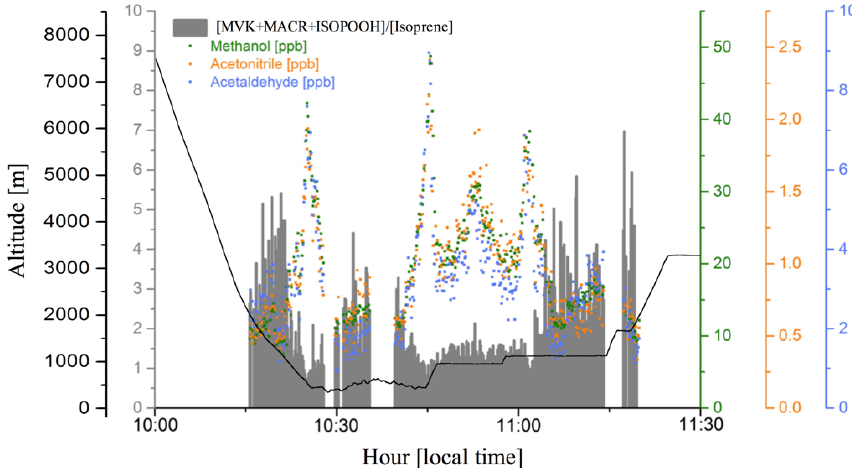
Figure 7. Methanol (green dots), acetonitrile (orange dots), and acetaldehyde (blue dots) mixing ratios (ppbv), and the [MVK + MACR + ISOPOOH] / [isoprene] ratio (gray bars), during a plume interception along the flight track B732 in different